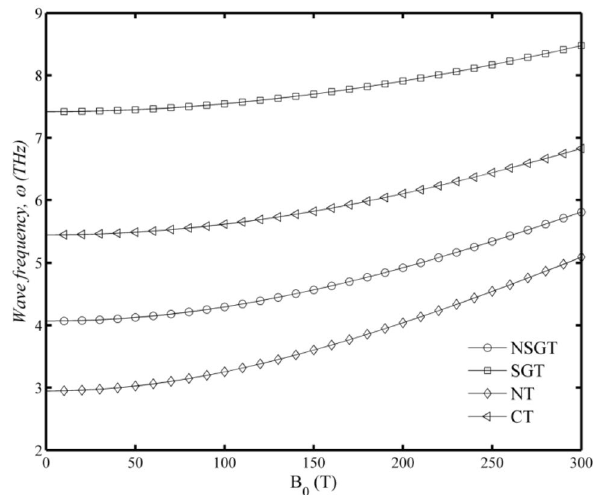
Fig. 6 The phase velocity regarding the fluid velocity in case of = 0.19 nm , ea = 0.3 nm and various k = 10 ( 1 ∕ nm ) , B 0 = 100 T , l m magnetic intensity